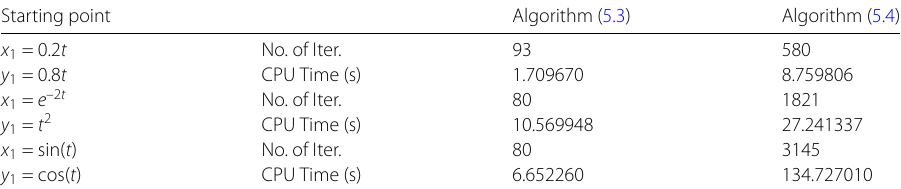
Table 5 Numerical values of Algorithm (5.3) and Algorithm (5.4) Starting point Algorithm (5.3) Algorithm (5.4) x 1 = 0.2